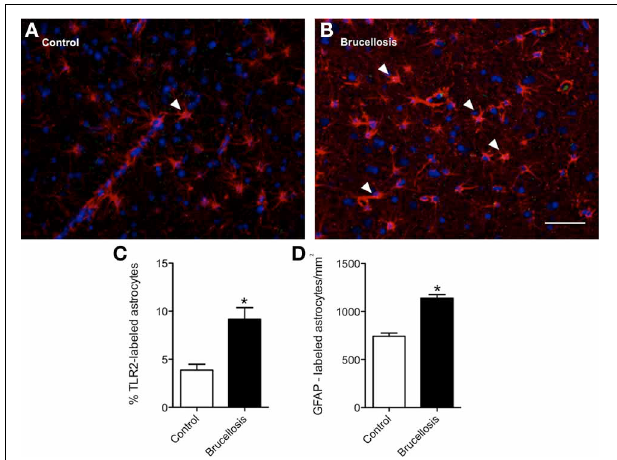
FIGURE 2 | Innate immune activation is coincident with increased astrocyte numbers in white matter. In control macaques, very few GFAP-positive (red) astrocytes express TLR2 (A , green). Arrowheads demonstrate double positive cells. In contrast, more astrocytes express TLR2 following infection with B. melitensis (B) . To confirm if this increase was significant, the proportion of double labeled cells was calculated. 3.9% of white matter astrocytes were TLR2 positive (C) . This increased to 9.2% ( P = 0.0008) with infection. This was coincident with an increased number of astrocytes within the white matter (D) . Due to the low expression of GFAP positive cells in cortical gray matter, the percentage of TLR2 and GFAP double-labeled astrocytes could not be evaluated quantitatively. Significance set at ∗ p < 0 . 05, Scale bar = 25um.